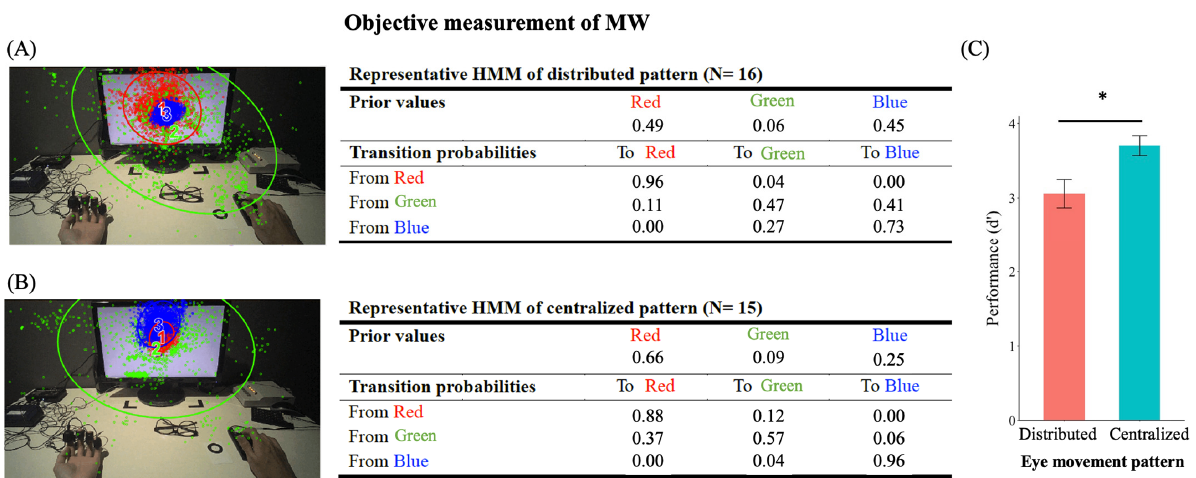
Figure 3. The two representative eye movement patterns during the 10-s pre-target period for ( A ) the distributed eye movement pattern and ( B ) the centralized eye movement pattern. The tables in the middle panel show the transition matrix among the ROIs. Prior values refer to the probability of the first fixation of a trial landed at a specific ROI. ( C ) d’ of participants with the two eye movement patterns as the objective measurement of MW. Error bars represent one S.E.M. * p < 0.05.